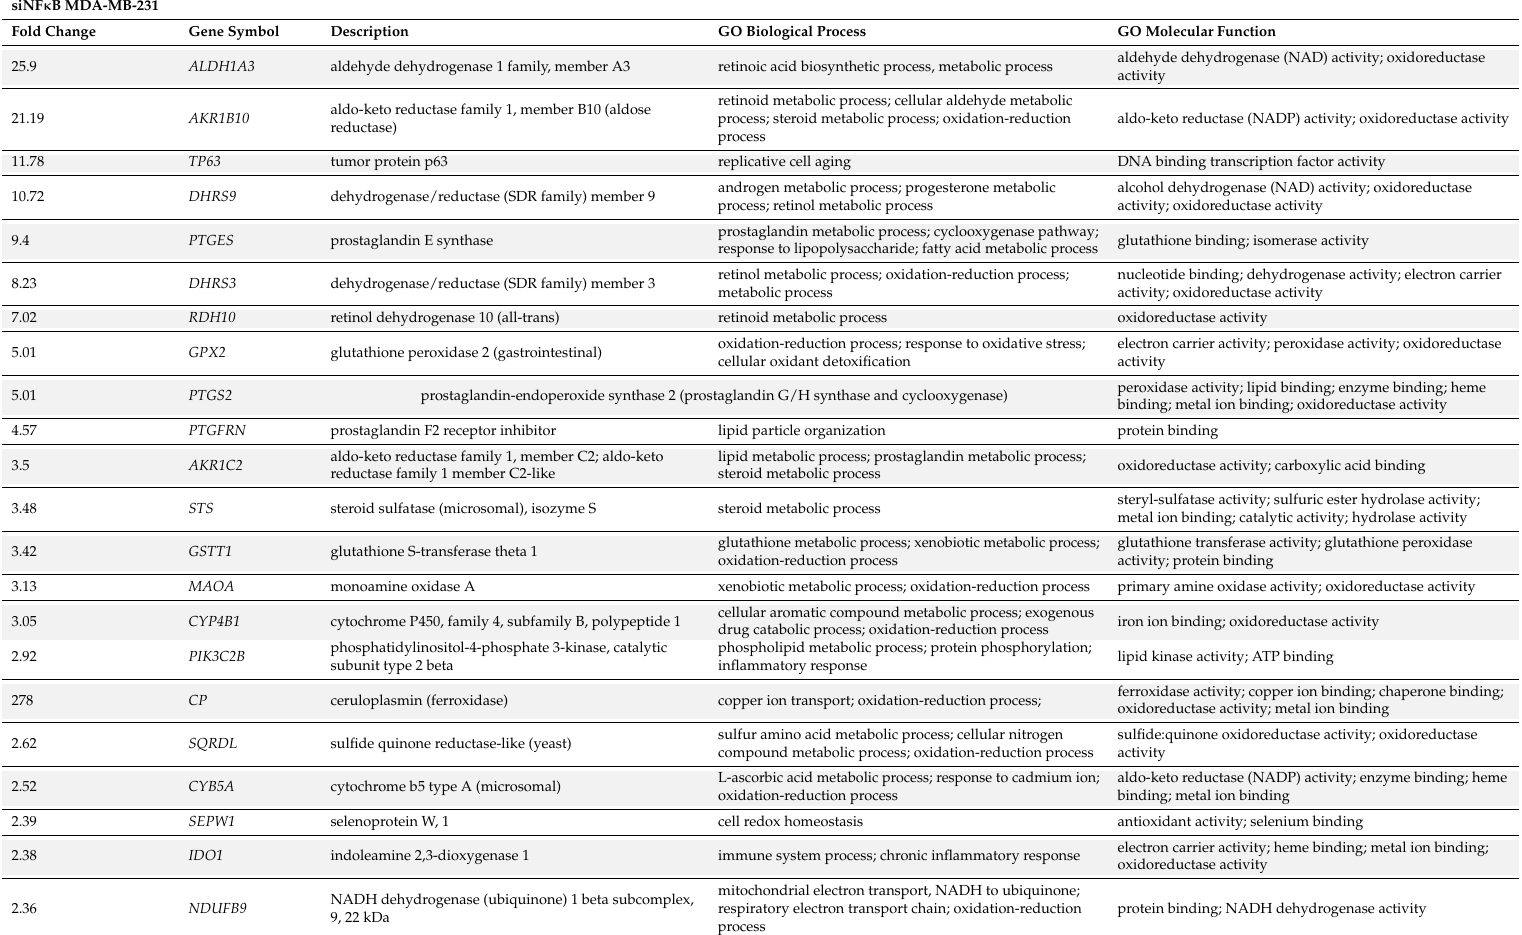
Table 2. List of oxidative stress–related genes with altered expression in NF- κ B-silenced breast cancer cell